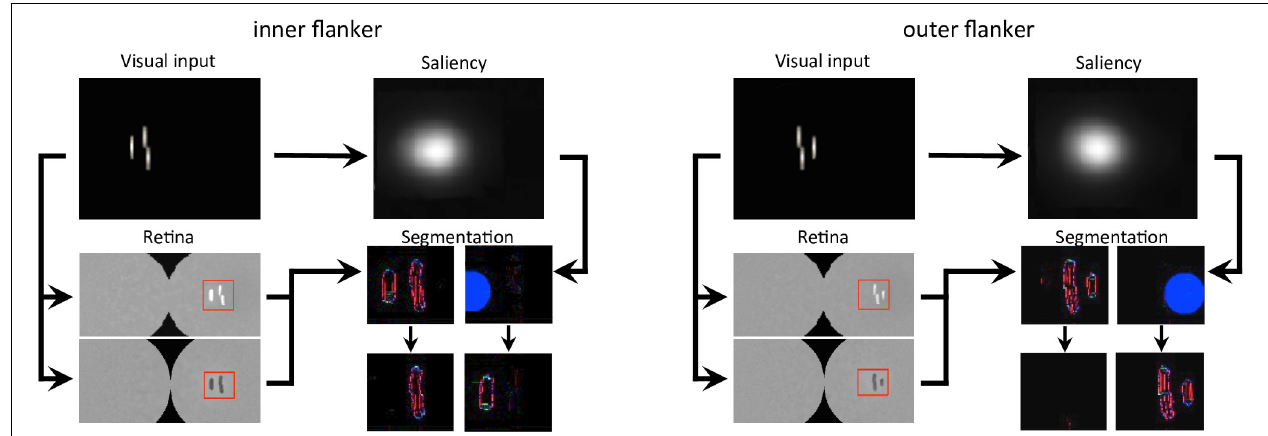
FIGURE 9 | Output of all models, for both flanked conditions of experiment 1b of Manassi et al. (2012; see Figure 3A ). The arrows represent the interactions that are described in Figure 7A . In the visual input and the saliency windows, the position of the fixation point corresponds to the center of the leftmost column. The retina window shows the output of the ON- and OFF-centered ganglion cells at the top and the bottom, respectively. The red rectangle highlights the portion of the ganglion cells output that is fed to the segmentation model, to gain computation time. The segmentation window shows the initial state of the model output in the first row, with an example of a selection signal occurrence, drawn from the saliency distribution (blue circle), and the resulting output of the model in the second row, after the segmentation dynamics have stabilized. Each column of the segmentation window corresponds to one segmentation layer, as in Figure 4 . Here, the inner flanker condition led to a successful segmentation trial, and the outer flanker condition led to a failed segmentation trial.